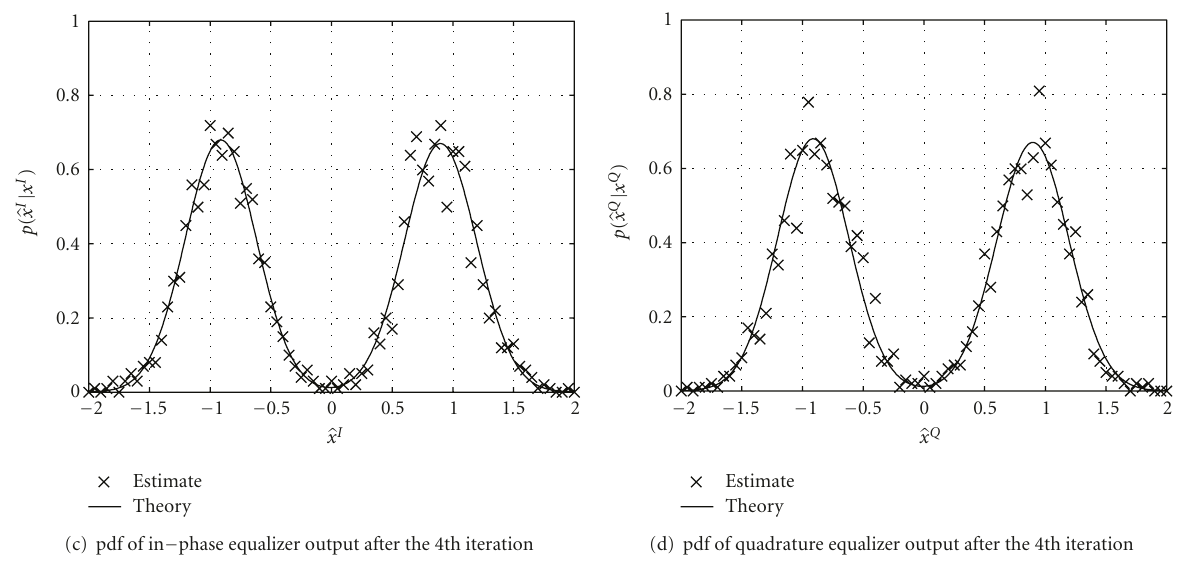
Figure 14: Experimental probability density function p ( (cid:17) x | x ) at the equalizer output.